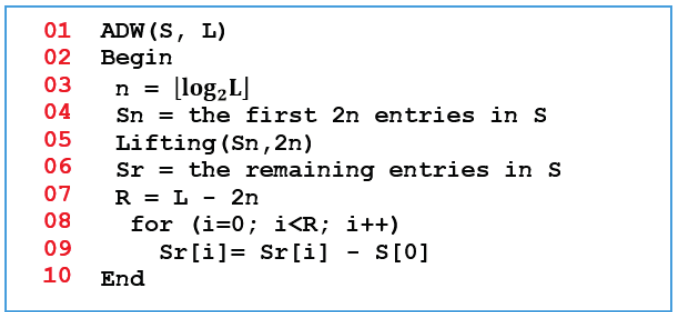
Figure 2. The Proposed Compression